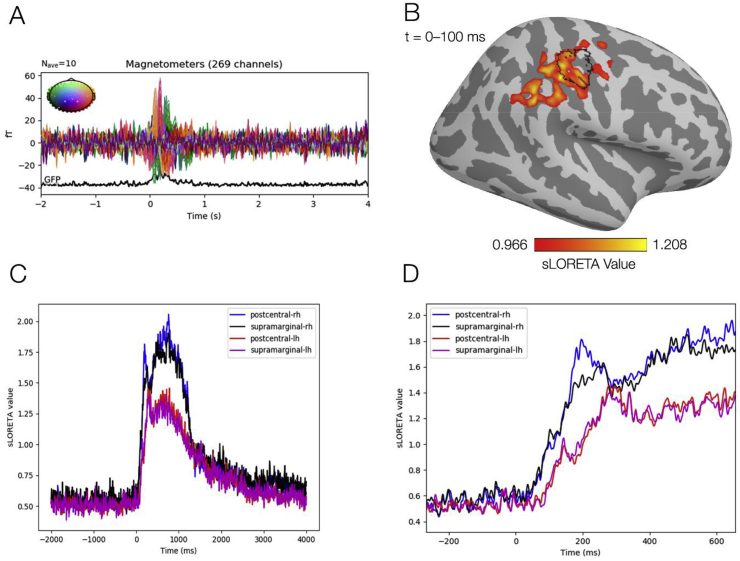
Results of a preliminary analysis into the early onset responses from INMS. A) A sensor-level grand average of the 10 FA1 units. B) A grand average sensor level plot of the first 100 ms of stimulation, showing the strongest sources in contralateral S1 (postcentral gyrus) and S2 (supramarginal) regions. For reference, the black overlay is the fMRI derived hand area (Sengupta et al., 2018). C) The average sLORETA timecourses from the left and right S1 and S2 areas. D) The same timecourses zoomed in to the first 600 ms, which shows the delayed ipsilateral response from both S1 and S2. An interactive version of the cortical plot can be found at http://georgeoneill.github.io.